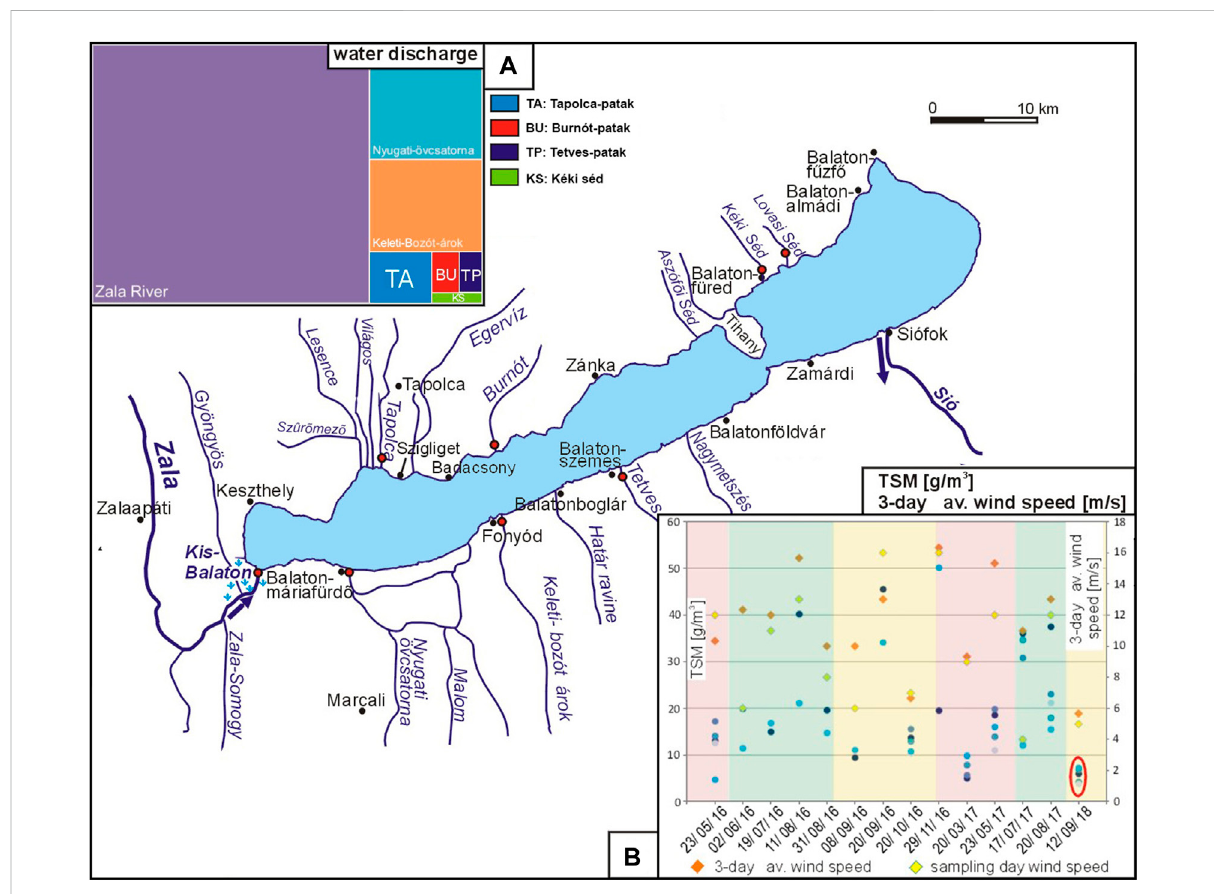
FIGURE 4 (A) Water discharge of the studied tributaries between 2016 and 2018, based on monthly average values (obtained from the of fi cial reports of the Central Transdanubia Water Directorate). (B) Total suspended matter (TSM; g m − 3 ) measured in Lake Balaton water and wind speed (m s − 1 ) averagedfor 3-dayperiodspreceding(andincluding)thedateofsampling.Thebackgroundcolorsofthecharts markseasons:pinkforspring,green for summer, yellow for autumn, and blue for winter. Red ellipse indicates a sample taken during a calm period (12 September